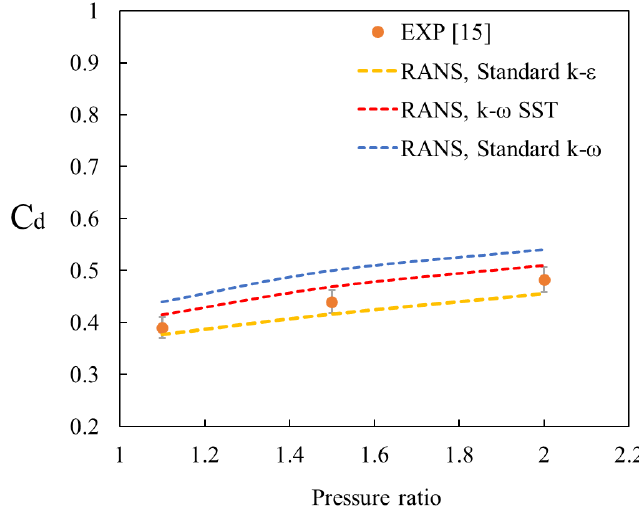
Figure 6. Effect of pressure ratio on the discharge coefficient of the baseline labyrinth seal. C d — discharge coefficient.